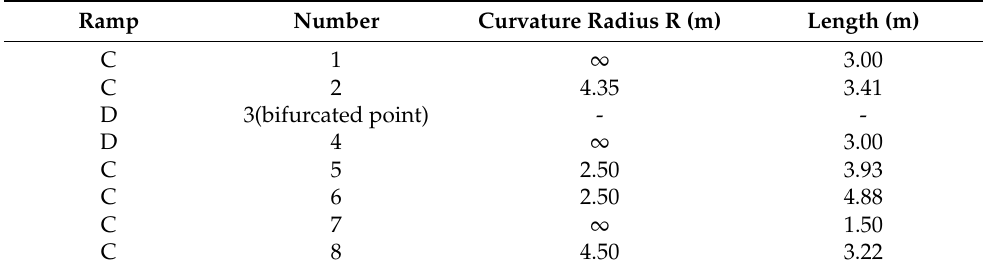
Figure 2. Schematic diagram of the different sections of the underground interconnected tunnel. Table 1. Parameters of different segments of the underground interconnected tunnel.